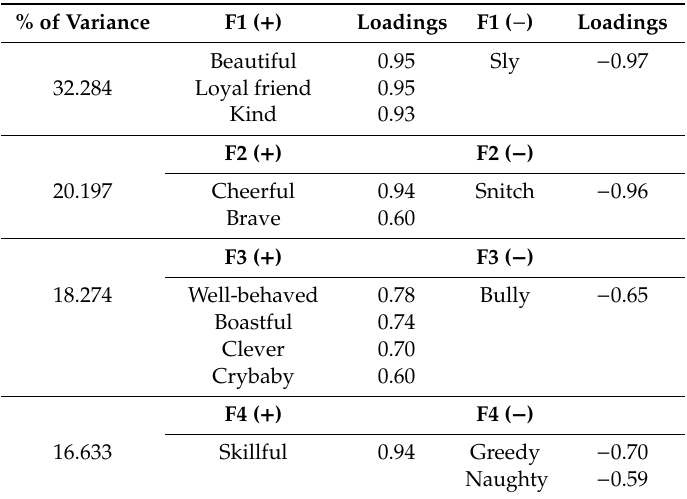
Figure 1. Semantic space of respondent N . Table 1. Factors: loadings and total variance (respondent N ).